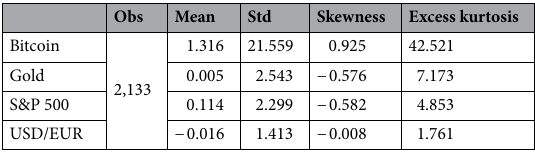
Table 1. Summary statistics of the annualized log